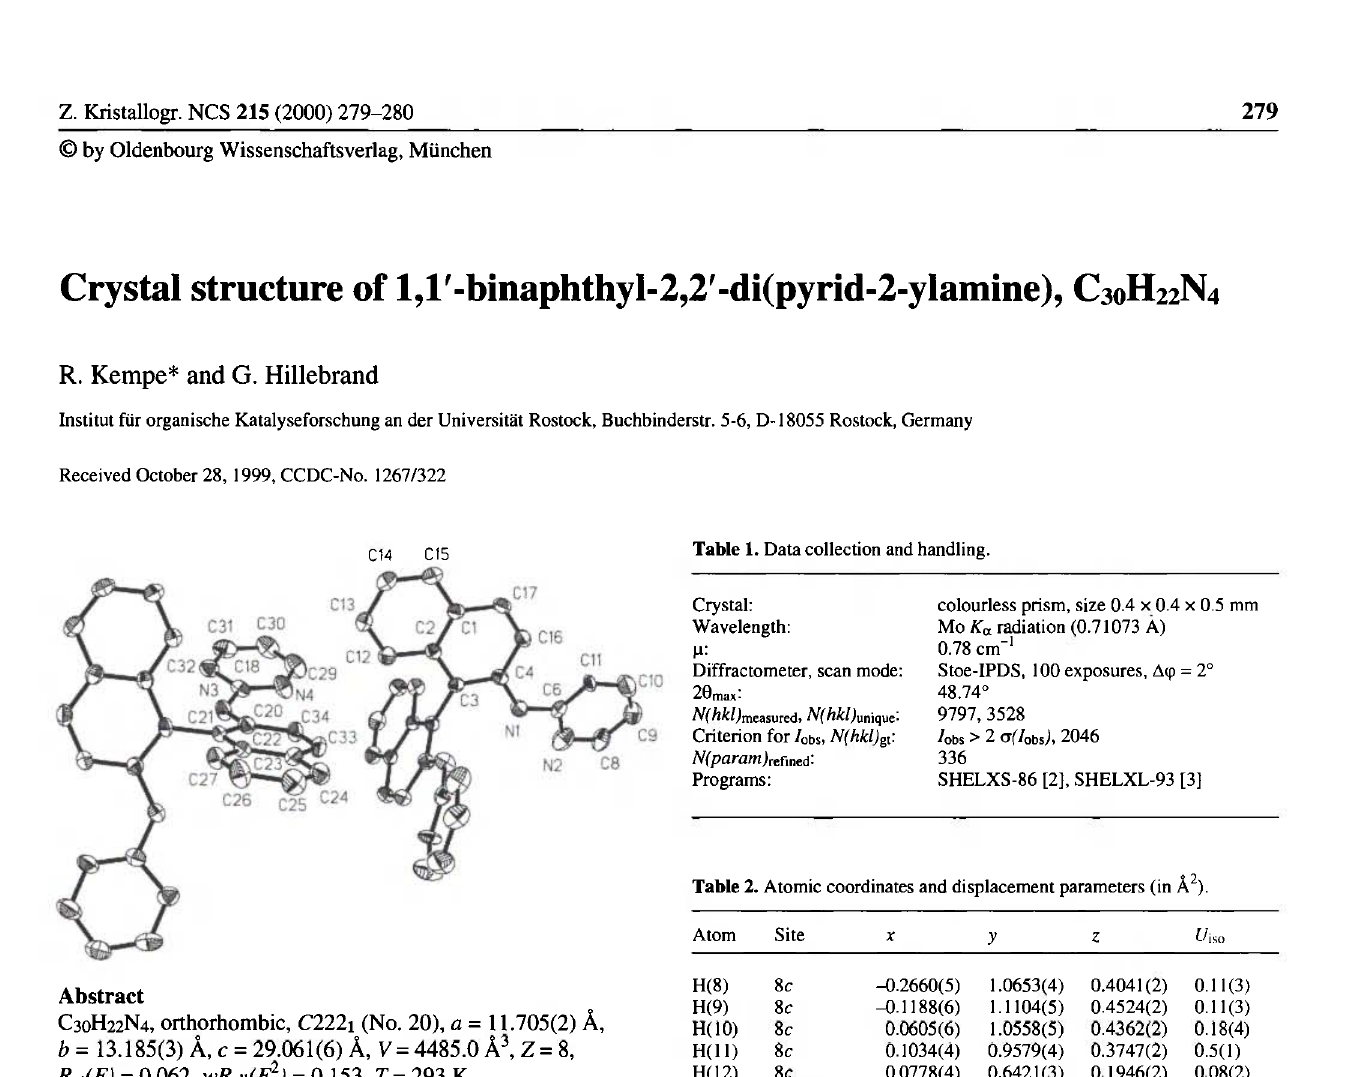
Table 2. Atomic coordinates and displacement parameters (in Ä 2